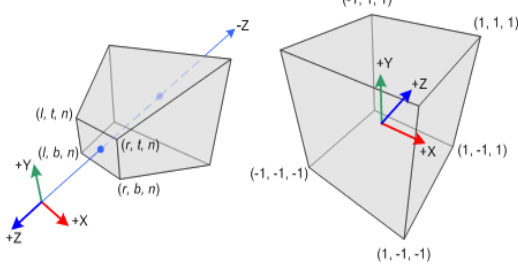
Figure 8 – Perspective Frustum and Normalized Coordinate Space It is possible to perceive that the Eye Coordinate System is defined according to the Right Hand Rule, however the Normalized Coordinate System is defined by the Left Hand Rule, meaning that the camera, in the origin, is looking to the – Z axis on the eye system but looking to the +Z axis on the Normalized Coordinate